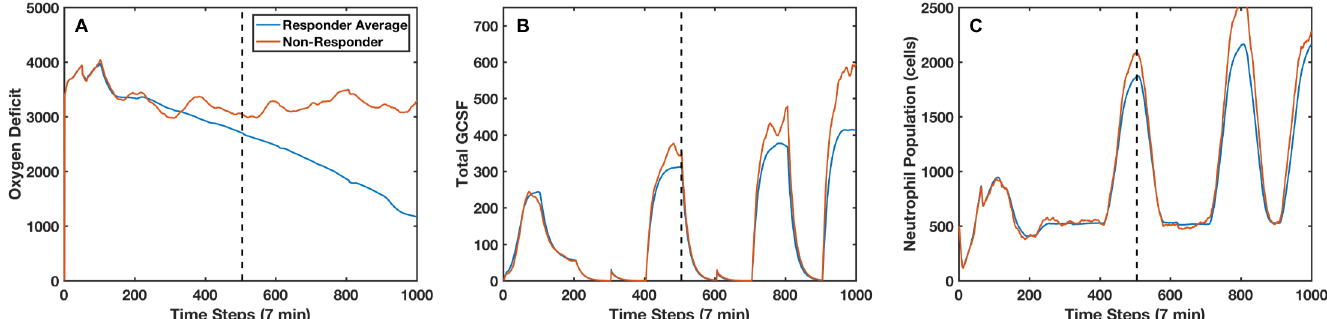
Fig 4. Non-responder system dynamics. Panel A displays the oxygen deficit (an inverse measure of the system’s health) for an intervention non-responder (red) compared to the average oxygen deficit for intervention responders (blue) over time. Panel B displays the total GCSF for the non-responder and the responder average; panel C displays the total neutrophil population for an individual non-responder and the responder average. In this case, the non-responder does not end up healing due to a hyper-productive response to GCSF pathway stimulation, which leads to a surplus neutrophil population; this patient ultimately dies due to inflammation, which is exacerbated by the applied